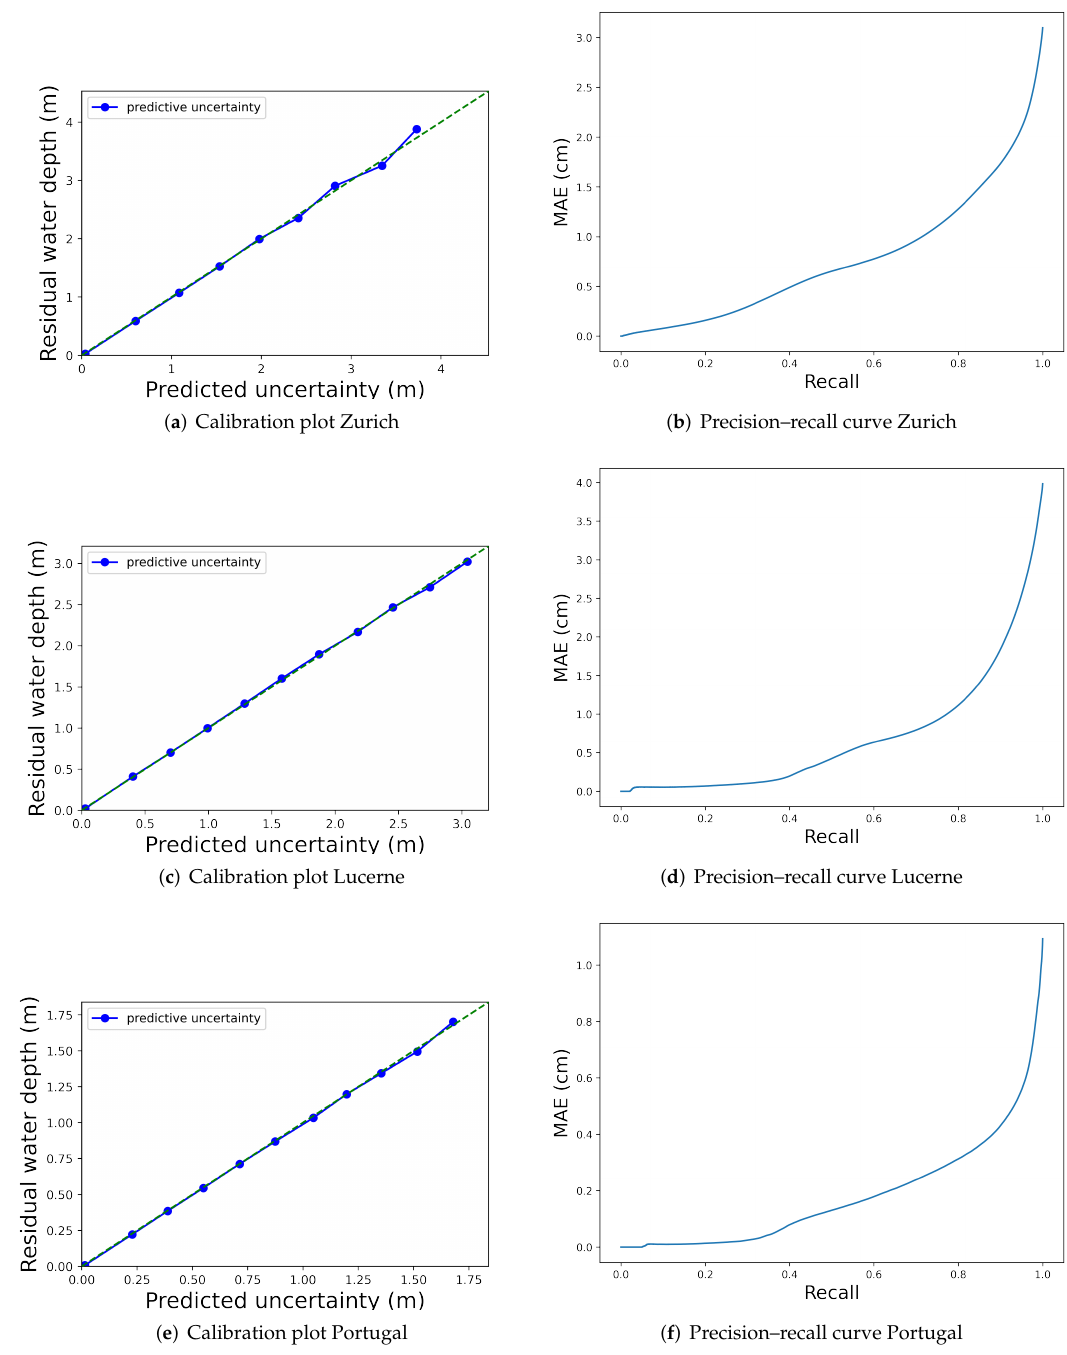
Figure A4. Evaluation of the predictive uncertainties predicted by Deep Flood for rainfall event tr100-1 on the Zurich, Lucerne, and Portugal test catchments. ( a ) The residuals in metres are plotted versus the grouped predicted uncertainties. ( b ) The test data are filtered based on the predictive uncertainty, showing a decrease in mean absolute error when high uncertainty test data points are